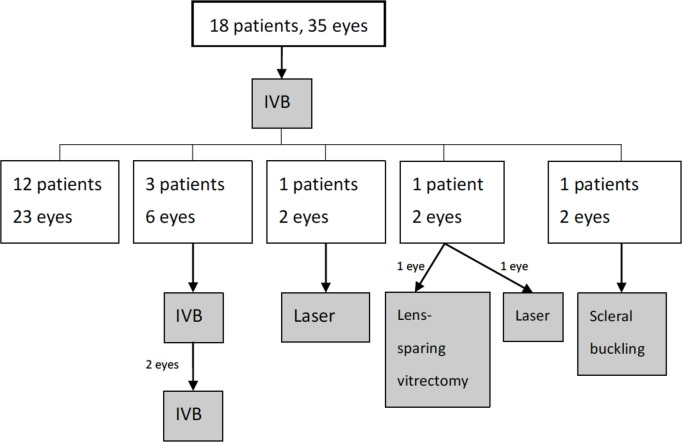
Algorithm demonstrating the structural outcomes after intravitreal bevacizumab treatment.